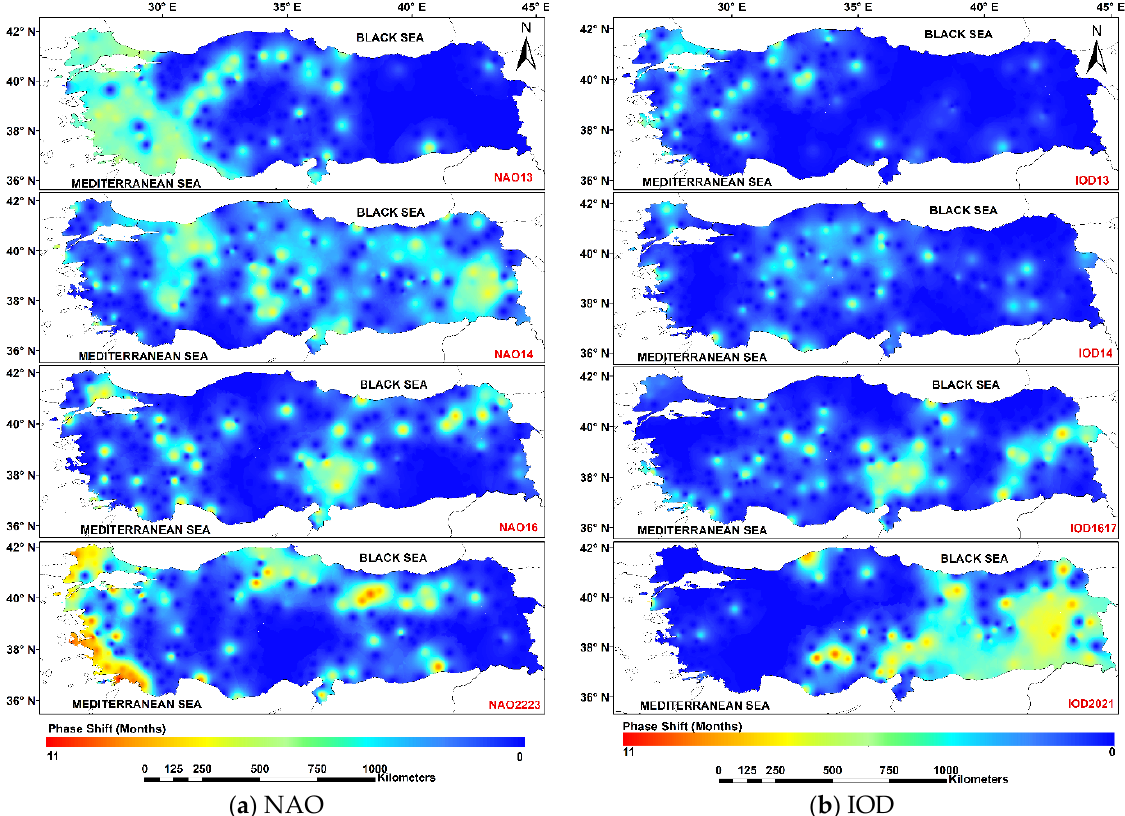
Figure 15. Spatial distribution of phase shifts ( a ) for NAO ( b ) for IOD.